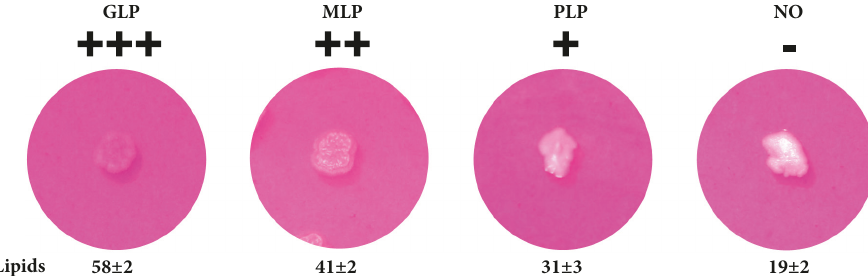
Figure 4: Qualitative response levels of the screening method for oleaginous yeasts. A close-up of single colonies is shown. The levels are defined as follows: GLP, good lipid producer; MLP, moderate lipid producer; PLP, poor lipid producer; and NO, non-oleaginous. The lipid percentage is presented as % of lipids, and the data are presented as the means and standard deviations from triplicate